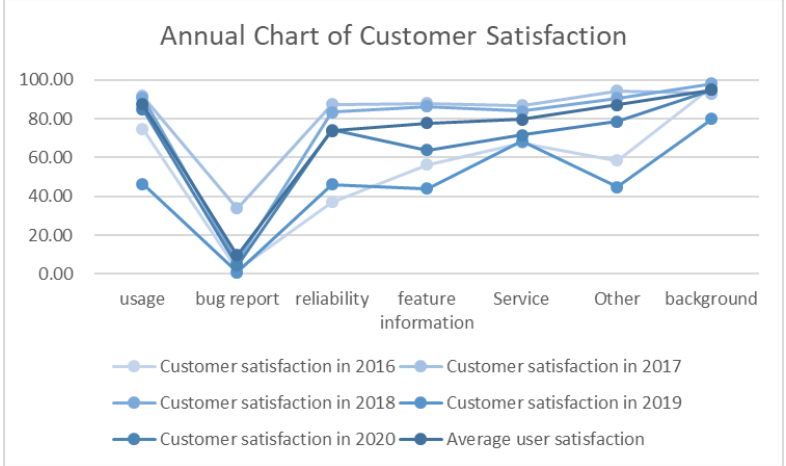
Figure 3. Annual Chart of Customer Satisfaction of the Ping An Health App.